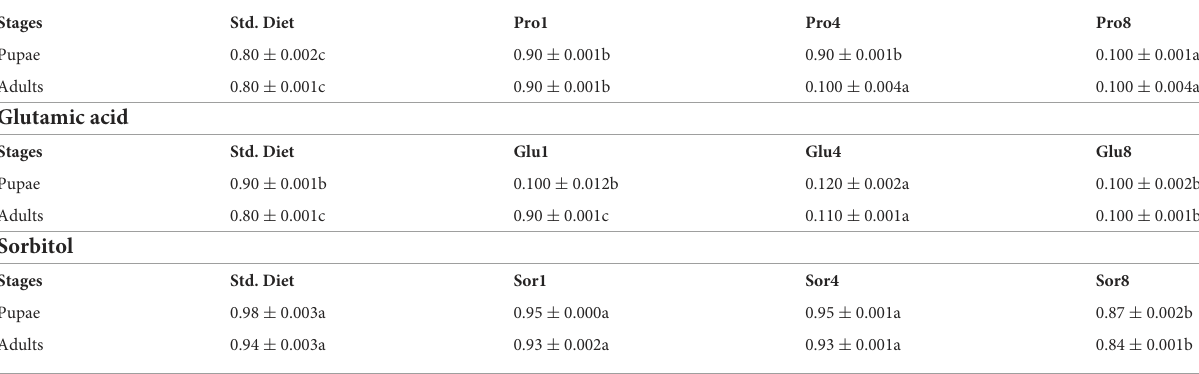
TABLE 4 The effect of different concentrations of proline, glutamic acid, and sorbitol (1, 4, and 8%) supplementation on body weight of bee brood (mg ± S.E) and standard diets fed to honey bee larvae.